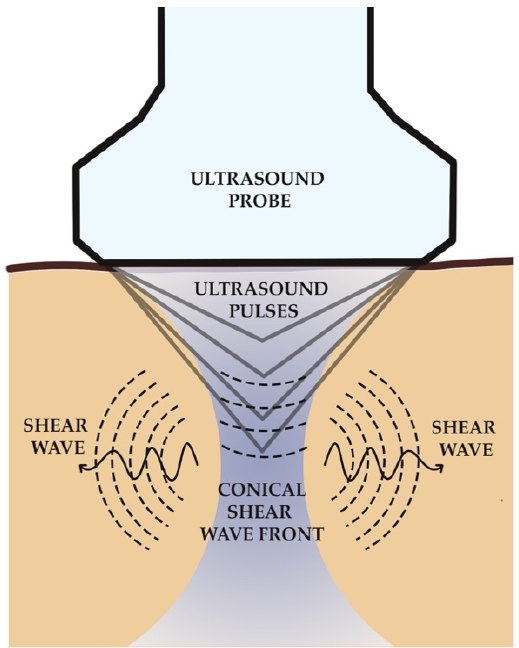
Figure 1. Basic principle of shear wave elastography (SWE). Ultrasound probe produces a localised radiation force deep in the tissue of interest, inducing a shear wave that propagates from this focal point. Numerous focal points are generated simultaneously in a line perpendicular to the skin surface. A conical shear wave front is created that sweeps the image plane on each side of the focal point. Adapted from Sigrist et al. [54] and Early et al. [55].